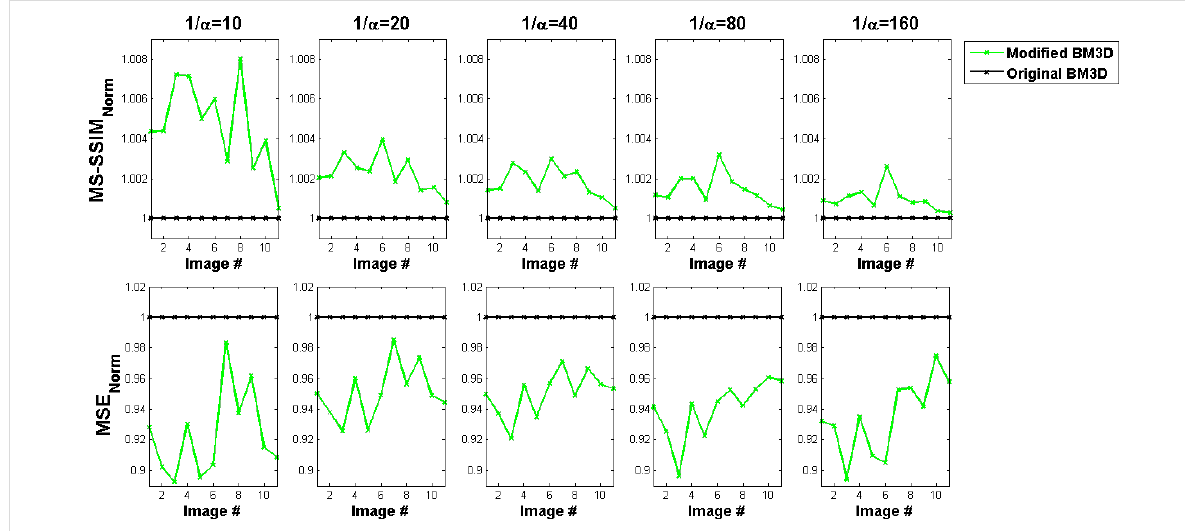
Figure 5: Quantitative evaluation of reconstructions by means of the original and the proposed version of the BM3D algorithm. Lower values of the parameter 1/ α imply higher noise variances. The green curves show relative values as compared to the original BM3D algorithm (black curves). Higher MS-SSIM-values and lower MSE values represent better results. The measurements show that our modified version of the BM3D algorithm generally improves image quality independent of the amount of noise (depending on α ) and the type of image (see Supporting Information File 1, Figure S2).